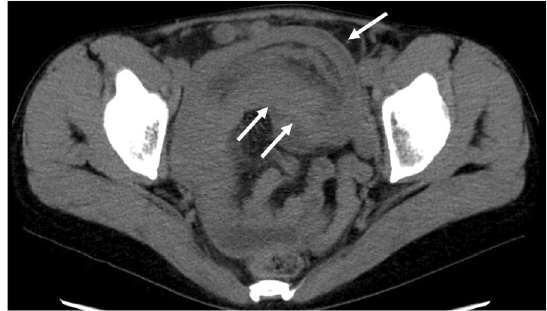
Fig. 1 Computed tomography findings on the first admission.